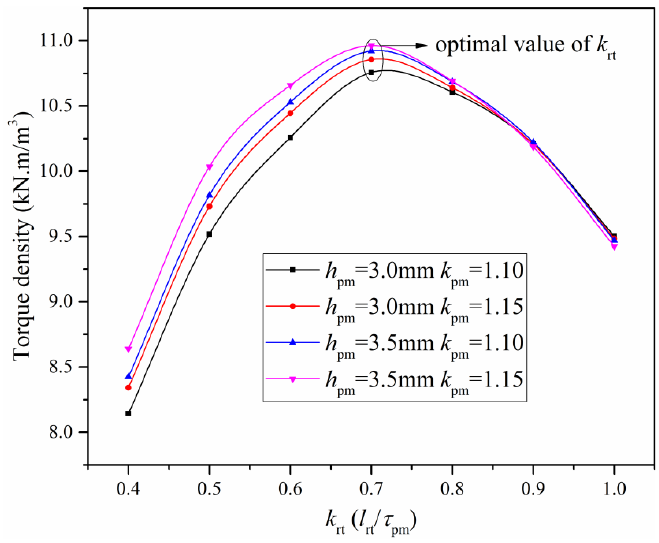
Figure 6. Influence of rotor length in the circumferential direction on torque density per volume.